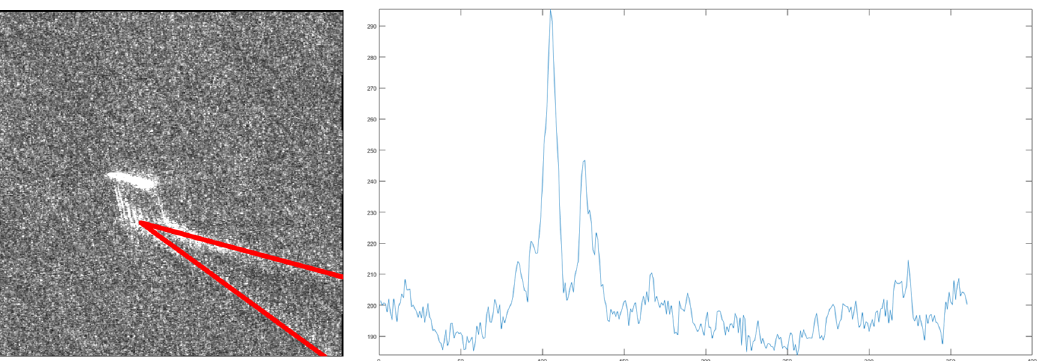
Figure 11. Example of wake linear components detection resulting from the identification of the histogram with larger peak response. (COSMO-SkyMed Product— c (cid:13) ASI 2016 processed